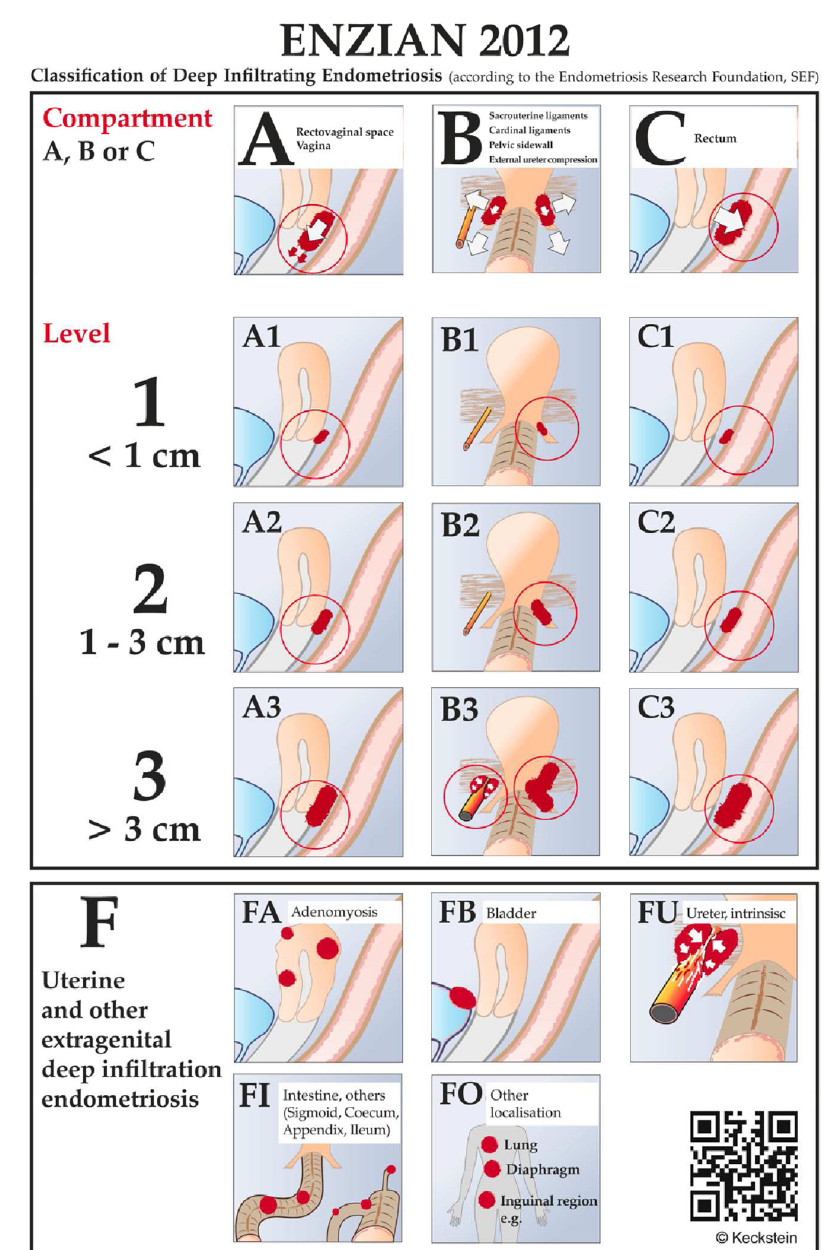
Figure 3. The Enzian classification for deep infiltrating endometriosis 51–53